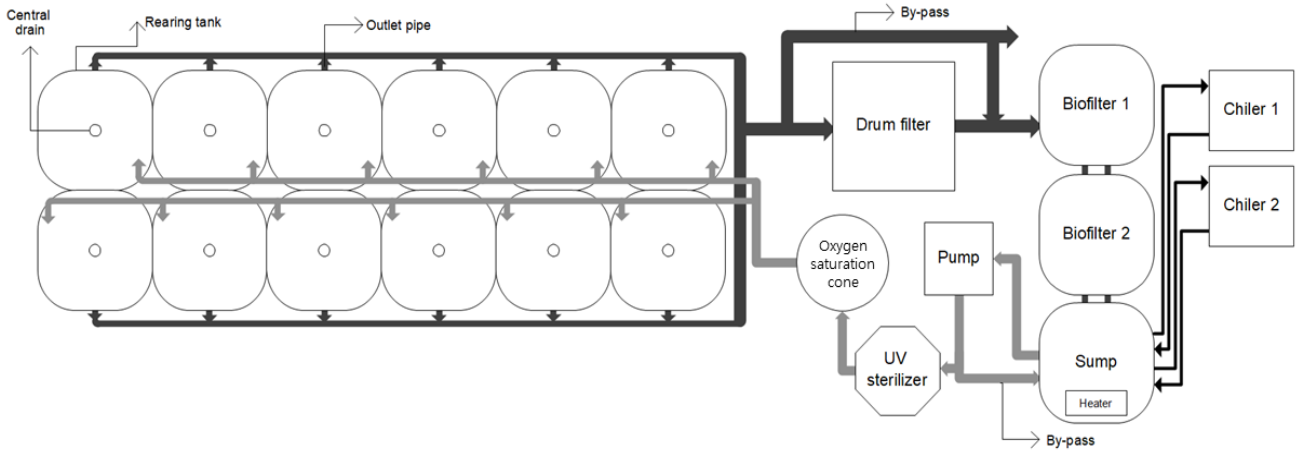
Figure 1. Schematic drawing of the experimental recirculating aquaculture system (dark arrows represent effluent, and gray arrows represent influent).